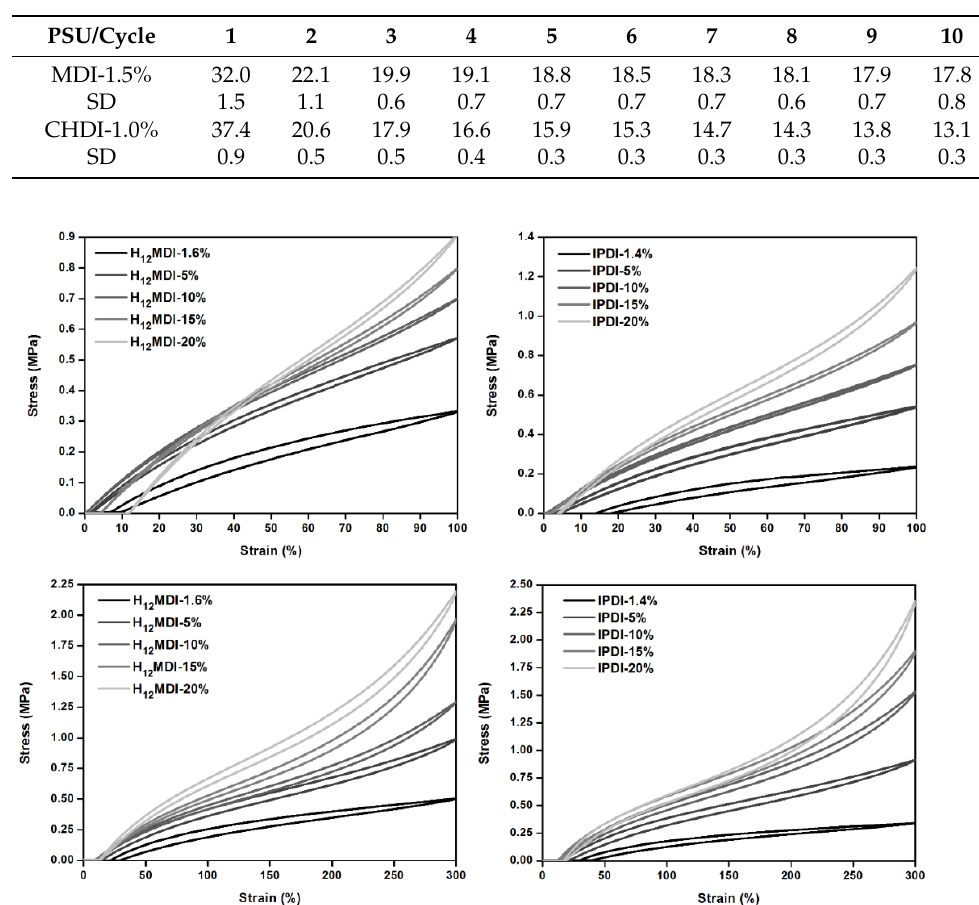
Table A7. Tensile hysteresis at 300% strain of PDMS-based polyurea copolymers synthesized from 4,4 (cid:48) -methylenebis(phenyl isocyanate) (MDI) and trans -1,4-cyclohexane diisocyanate (CHDI) with urea HSs of approximately 1.5% and 1.0%. Values are given as an average of three repeated measurements. SD: standard deviation.